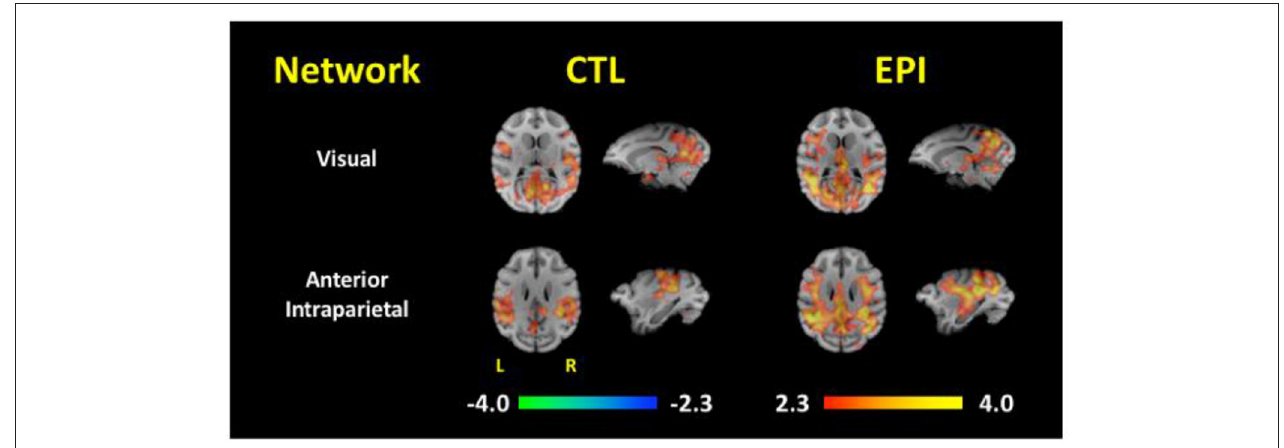
FIGURE 4 | Functional Connectivity Maps for the Visual and Anterior Parietal Networks. Functional connectivity maps are compared between asymptomatic healthy control (CTL) and epileptic (EPI) baboons. Note the increased connectivity of both visual and anterior partial networks to the medial thalamus and frontocentral cortices [Adapted from Epilepsia , reference